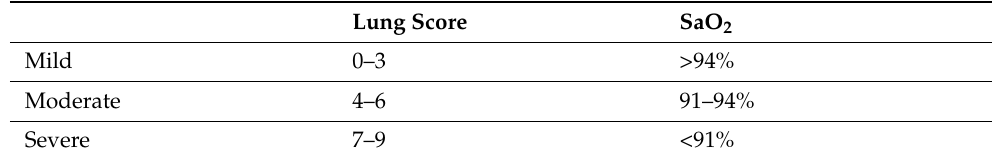
Table 2. Global assessment of asthma exacerbation in children, including pulmonary score and oxygen saturation based on the Spanish asthma management guide GEMA 5.0